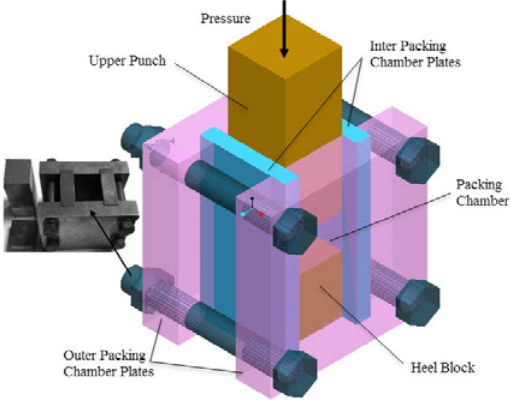
Figure 11. Mold-pressing equipment of twisted short